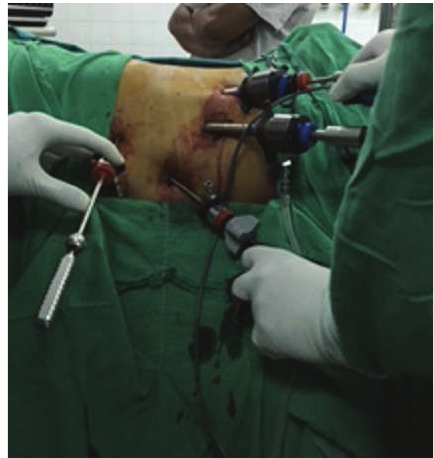
Figure 2: Patient operated on in right lateral position with head-up tilt using ports arranged as in this image.